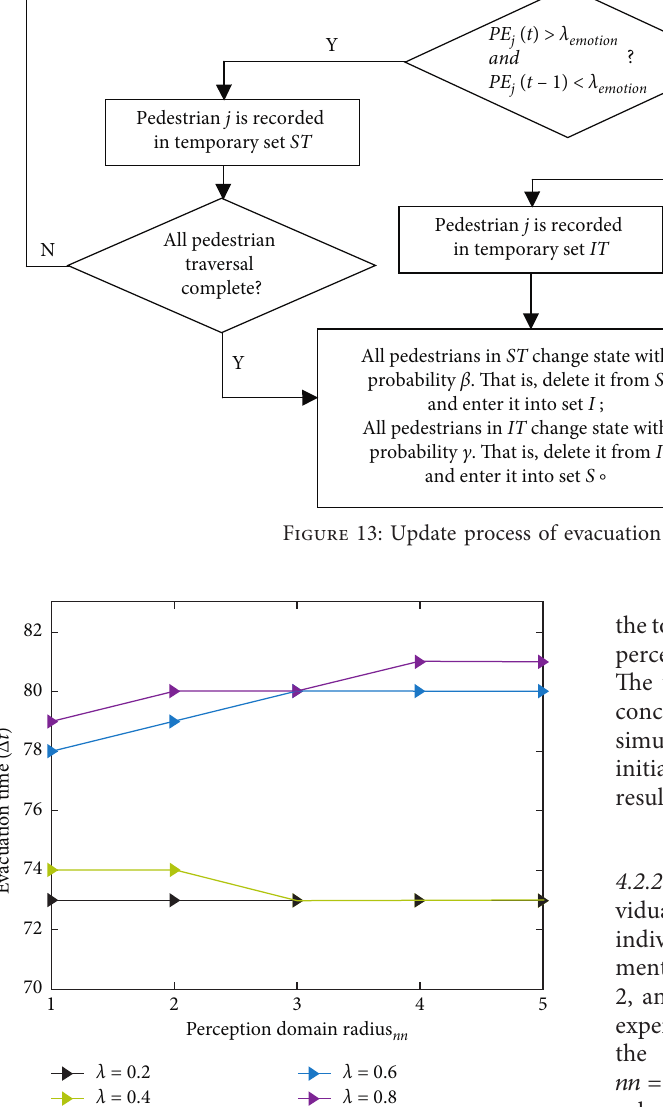
Figure 14: Total evacuation time with different perception domain radius in scenario 1 ( β � 0 . 33, c � 0 .